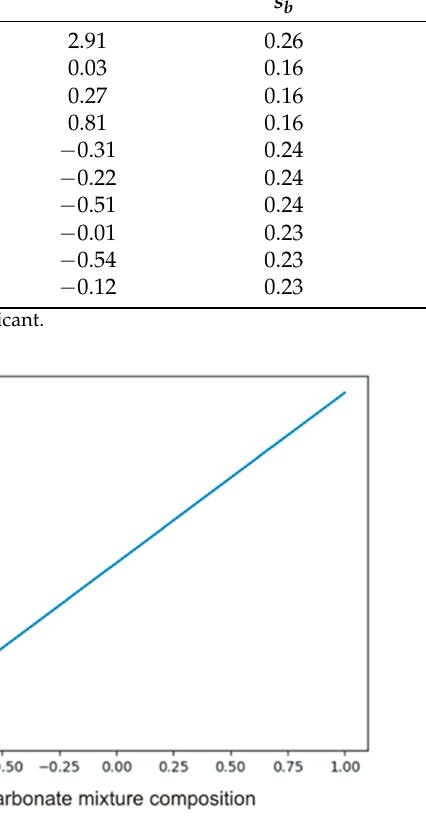
Figure 10. The plot of the function described by Equation (18).